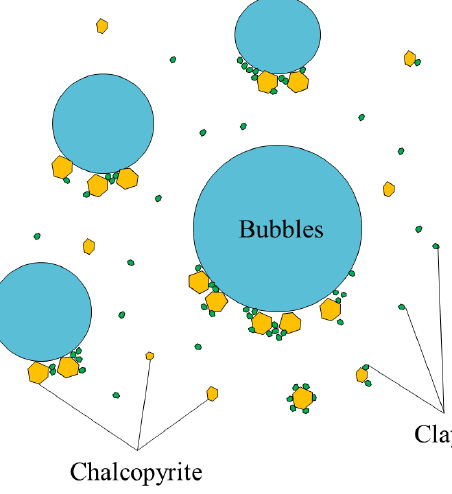
Figure 6. Adhesion of hydrophobized mineral and clays to a bubble.